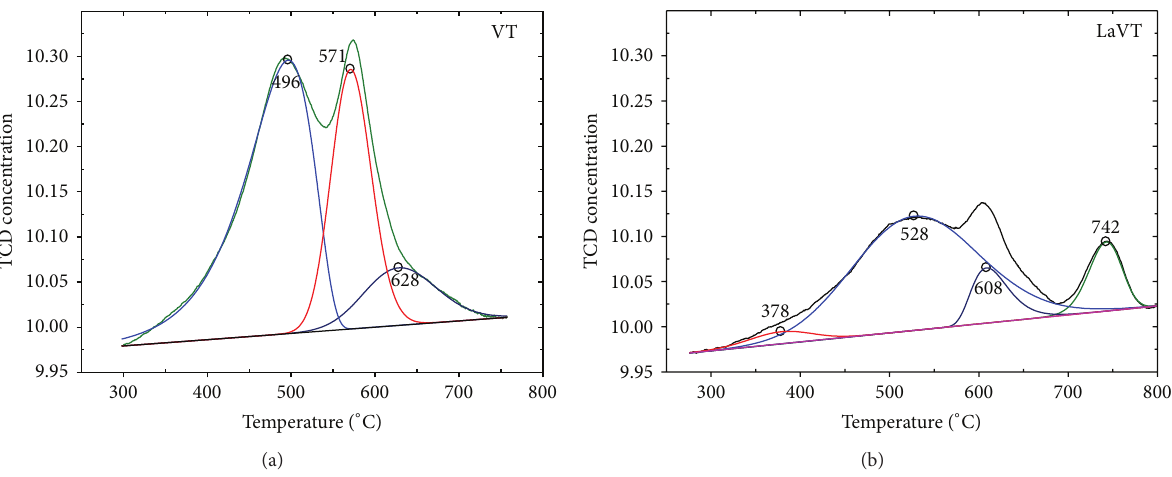
Figure 4: H 2 -TPR profiles of VT (a) and LaVT (b) catalysts.